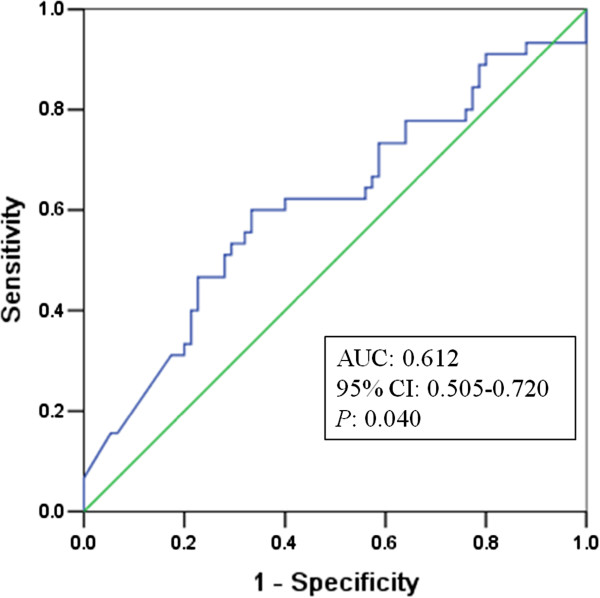
ROC curve for the 1-year death. AUC with the 95% CI is noted in the graph inset; the P value is with regard to testing the prognostic accuracy against the null hypothesis (area = 0.5).